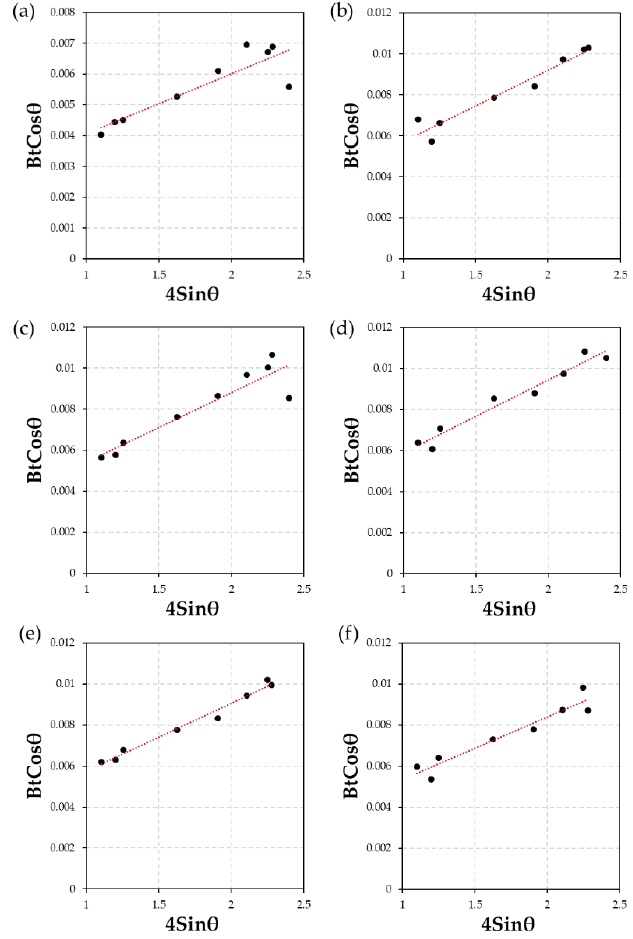
Figure 10. The Williamson-Hall plots for ( a ) the CS Zr powder and CS Zr coatings ( b ) S1, ( c ) S2, ( d ) S3, ( e ) S4, and ( f )